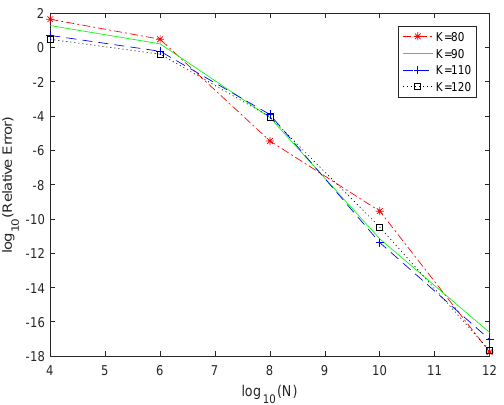
Figure 2. Relative errors for BS model with payoff b ( s ) = ( K − s ) + and finite expiry time T =